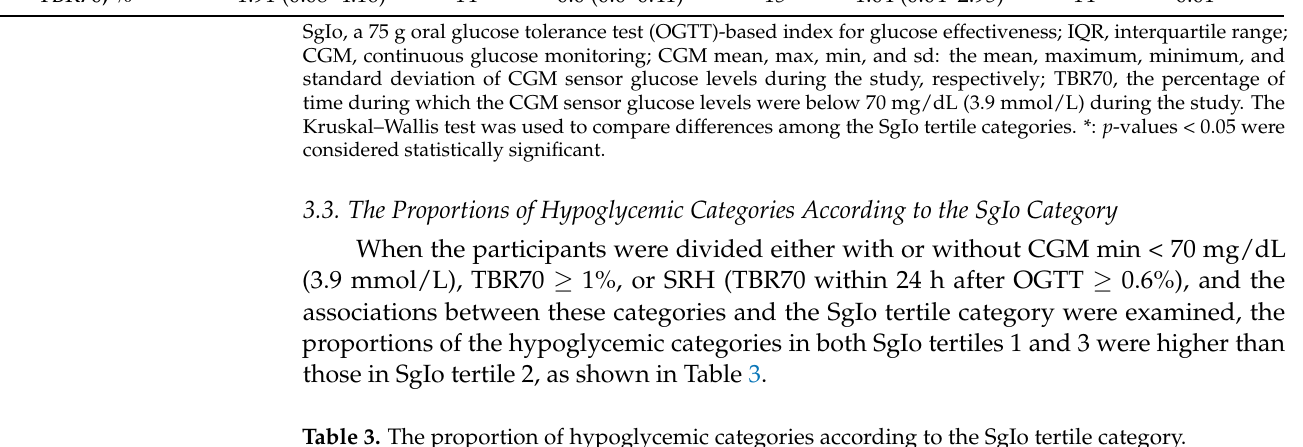
Table 3. The proportion of hypoglycemic categories according to the SgIo tertile